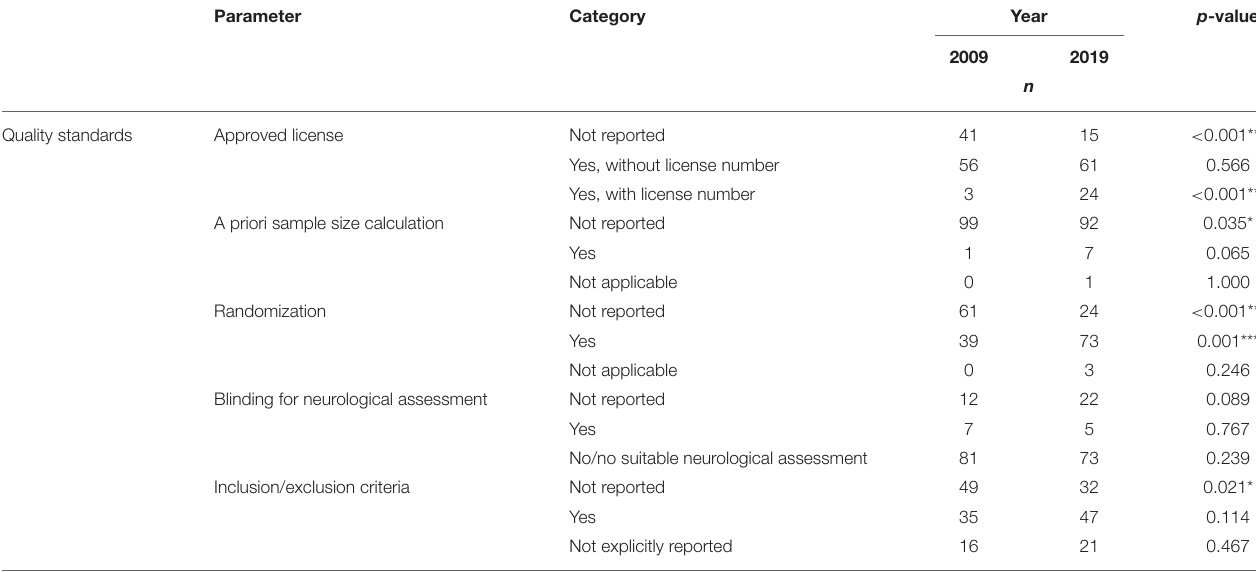
TABLE 4 | General quality standards extracted from the studies included in the review.